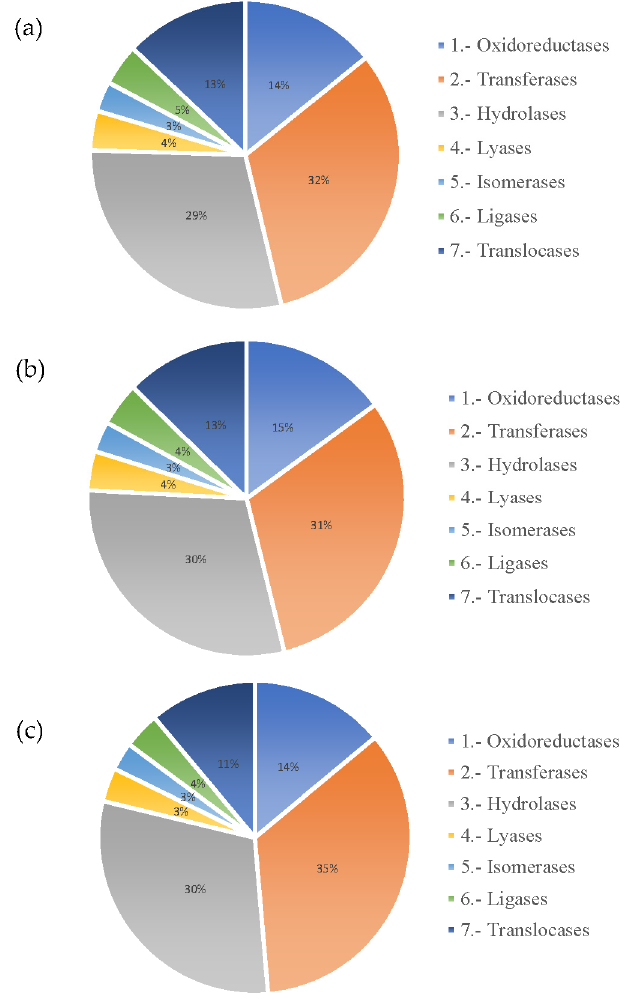
Figure 5. Distribution of protein classes identified on flower part of three species Hoya ; ( a ) H. cagayanensis ; ( b ) H. lacunosa , and ( c ) H. coriacea. Each area of the pie represents a value from the unigen.